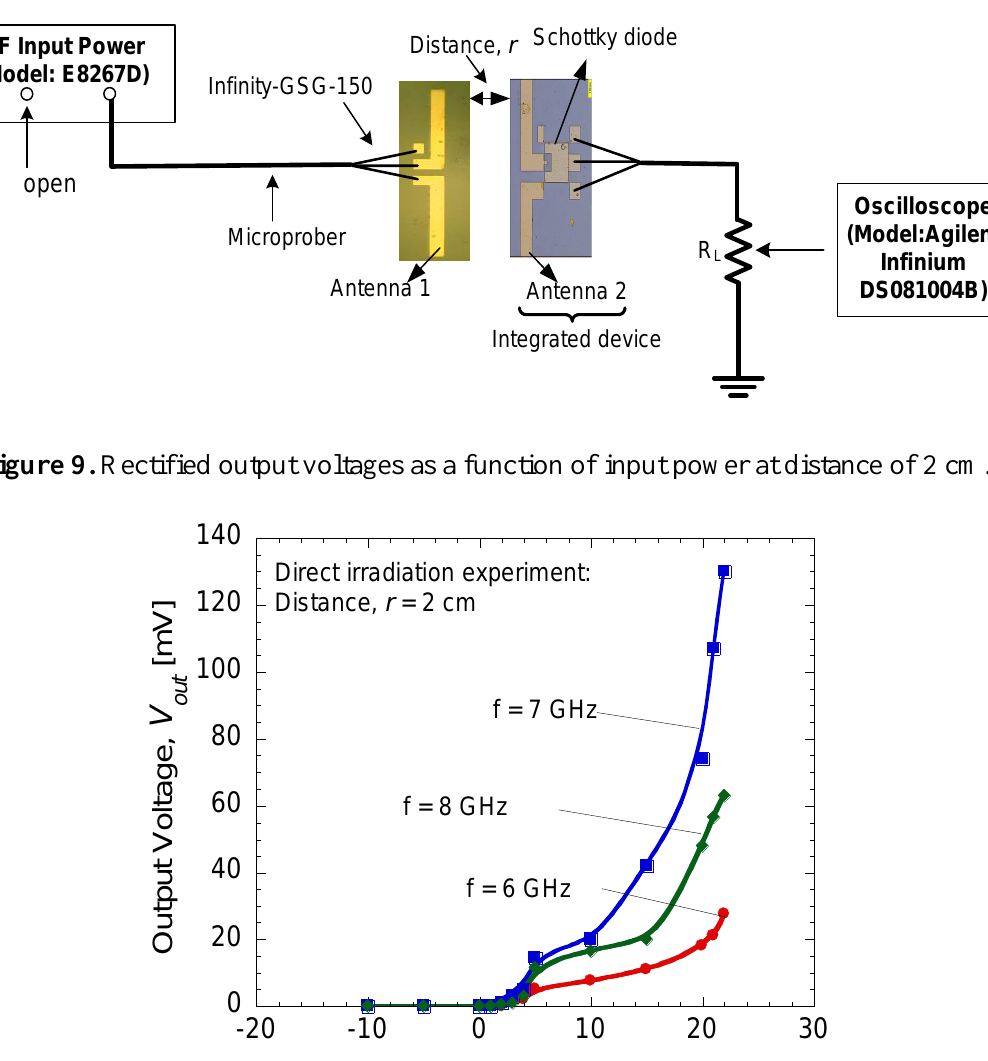
Figure 8. Measurement configuration for direct irradiation from antenna-to-antenna.